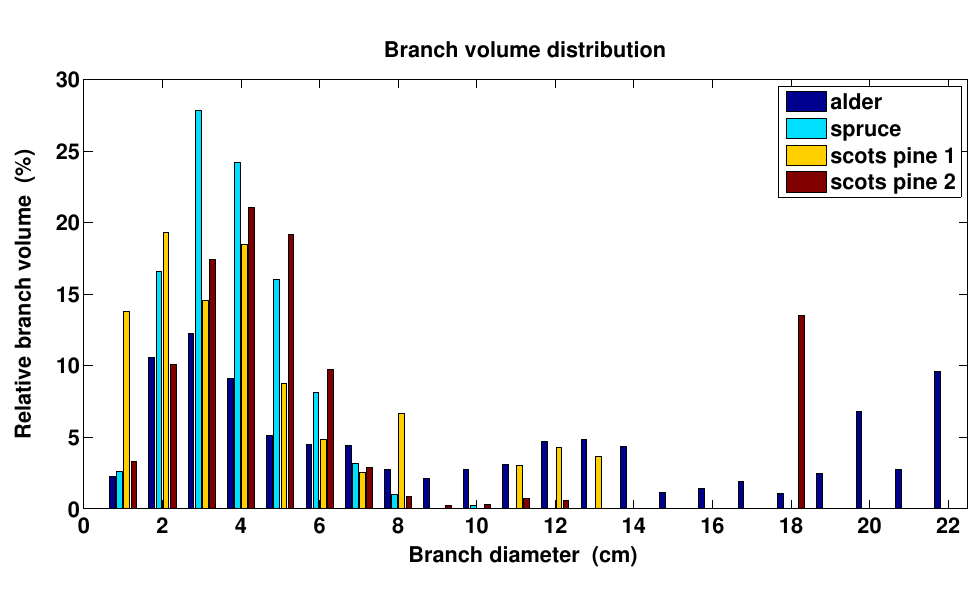
Figure 16. Branch size distributions.